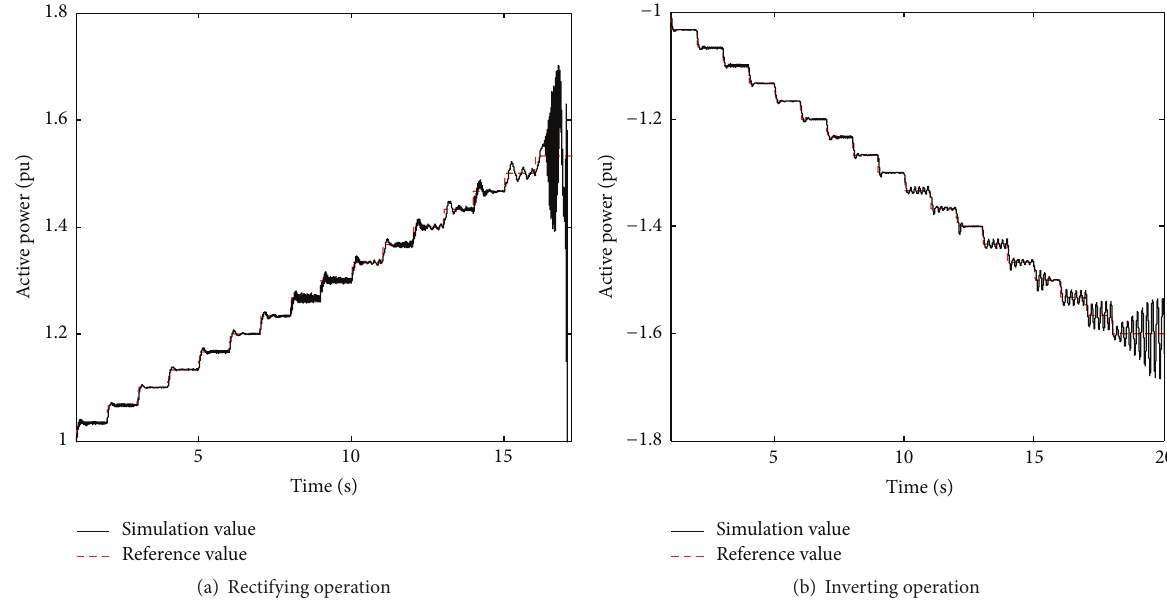
Figure 11: The simulation results of system with proposed PLL control.